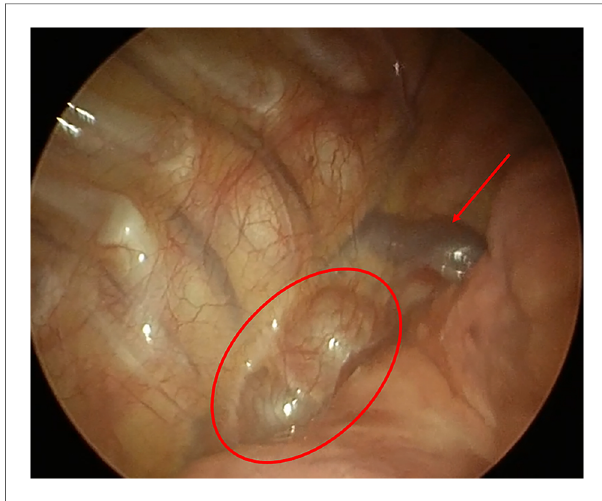
FIGURE 3 Foregut duplication cysts. Intrathoracic picture (arrow: azygos vein; circle: EDCs).